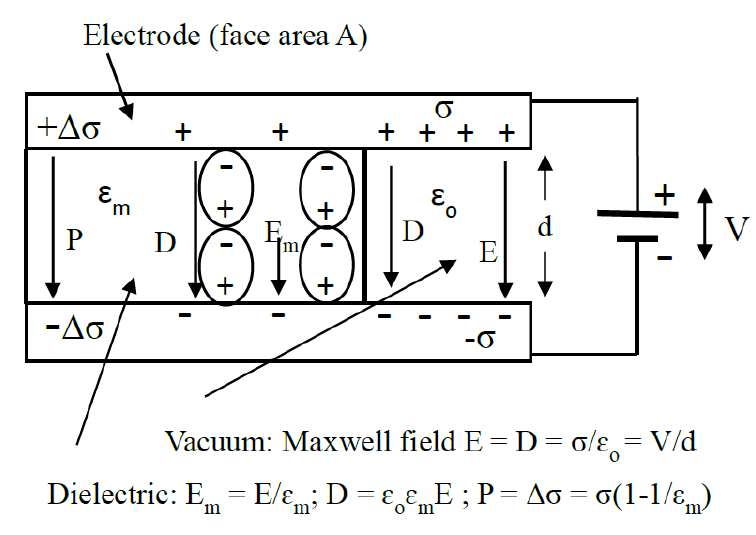
Figure 1. A dielectric of relative permittivity ε m is shown partly inserted between two electrified electrodes. ‘Free’ charge density σ on the electrodes creates the Maxwell field E and electric displacement D (both = σ / ε o ). ‘Bound’ charge density ∆ σ created by polarization (charge displacement) of the dielectric generates the polarization vector P ( ∆ σ = P s · ˆ n = P ), and equates to the number density of polarized molecules—i.e., the dielectric’s dipole moment M per unit volume. These relationships give D = E + P / ε o , and P = ε o ( ε m − 1)E o = χ m ε o E o .